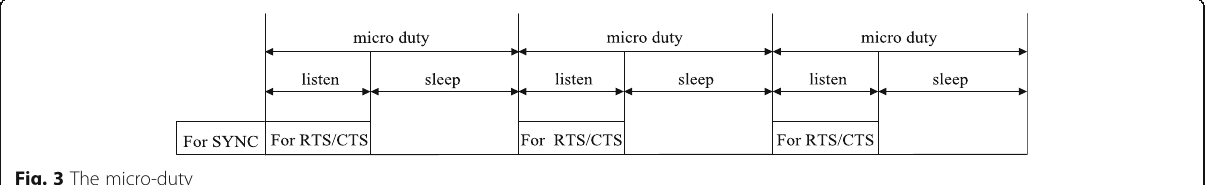
S-MAC protocol use BEB back-off [9] algorithm re- gardless of the current network traffic condition.